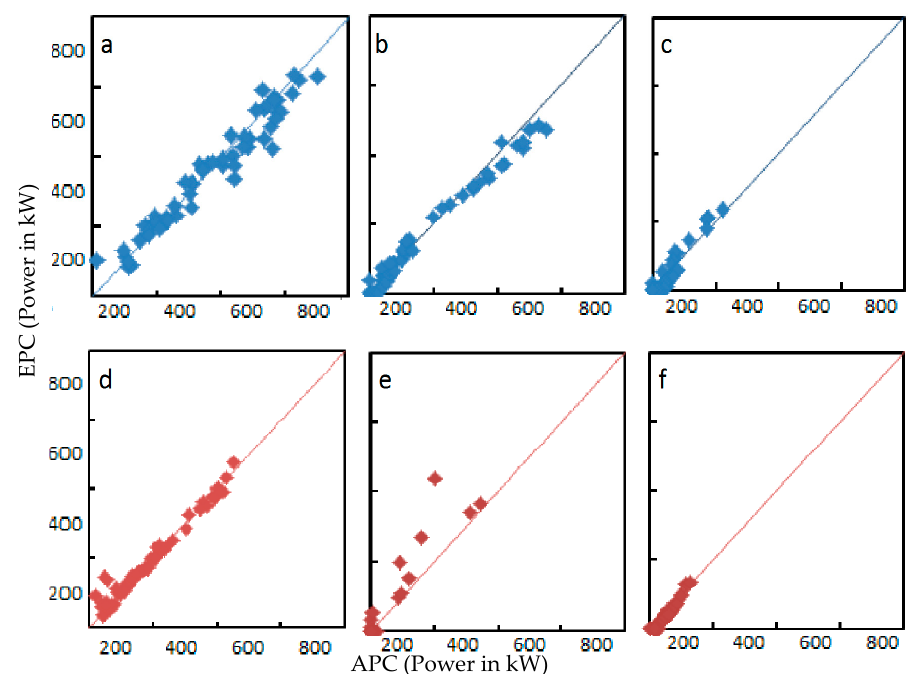
Figure 6. Comparison of 15-min actual output in kW (APC) and modelled output (EPC) in kW for: scenario A in ( a ) winter and ( d ) summer; scenario B in ( b ) winter and ( e ) summer; and scenario C in ( c ) winter and ( f ) summer.